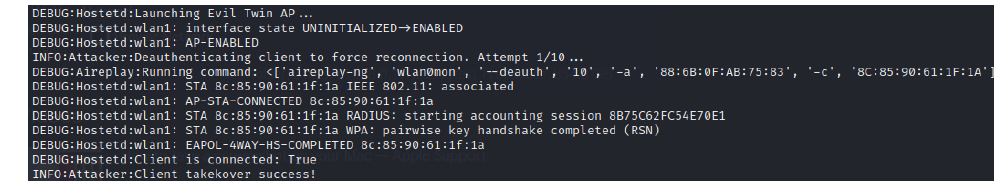
Figure 13. Debug view of Evil Twin connection.